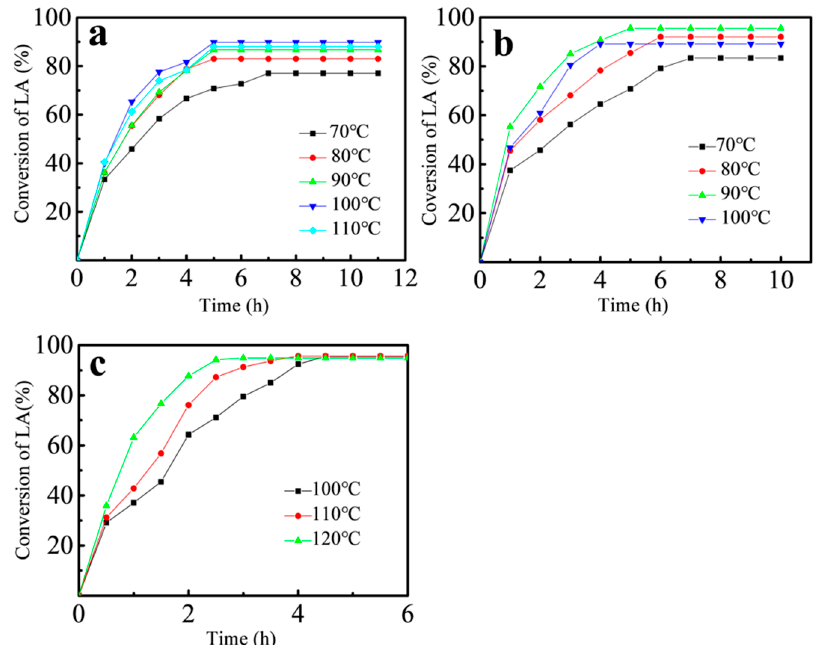
Figure 9. Effect of reaction time on the esterification of levulinic acid with ( a ) ethanol operated at reaction temperature: 70–110 °C, reaction time: 11 h, and catalyst mass: 0.116 g, ( b ) n-butanol operated at reaction temperature: 70–100 °C, reaction time: 10 h, and catalyst mass: 0.116 g, and ( c ) n-caprylic operated at reaction temperature: 100–120 °C, reaction time: 6 h, and catalyst mass: 0.116 g.